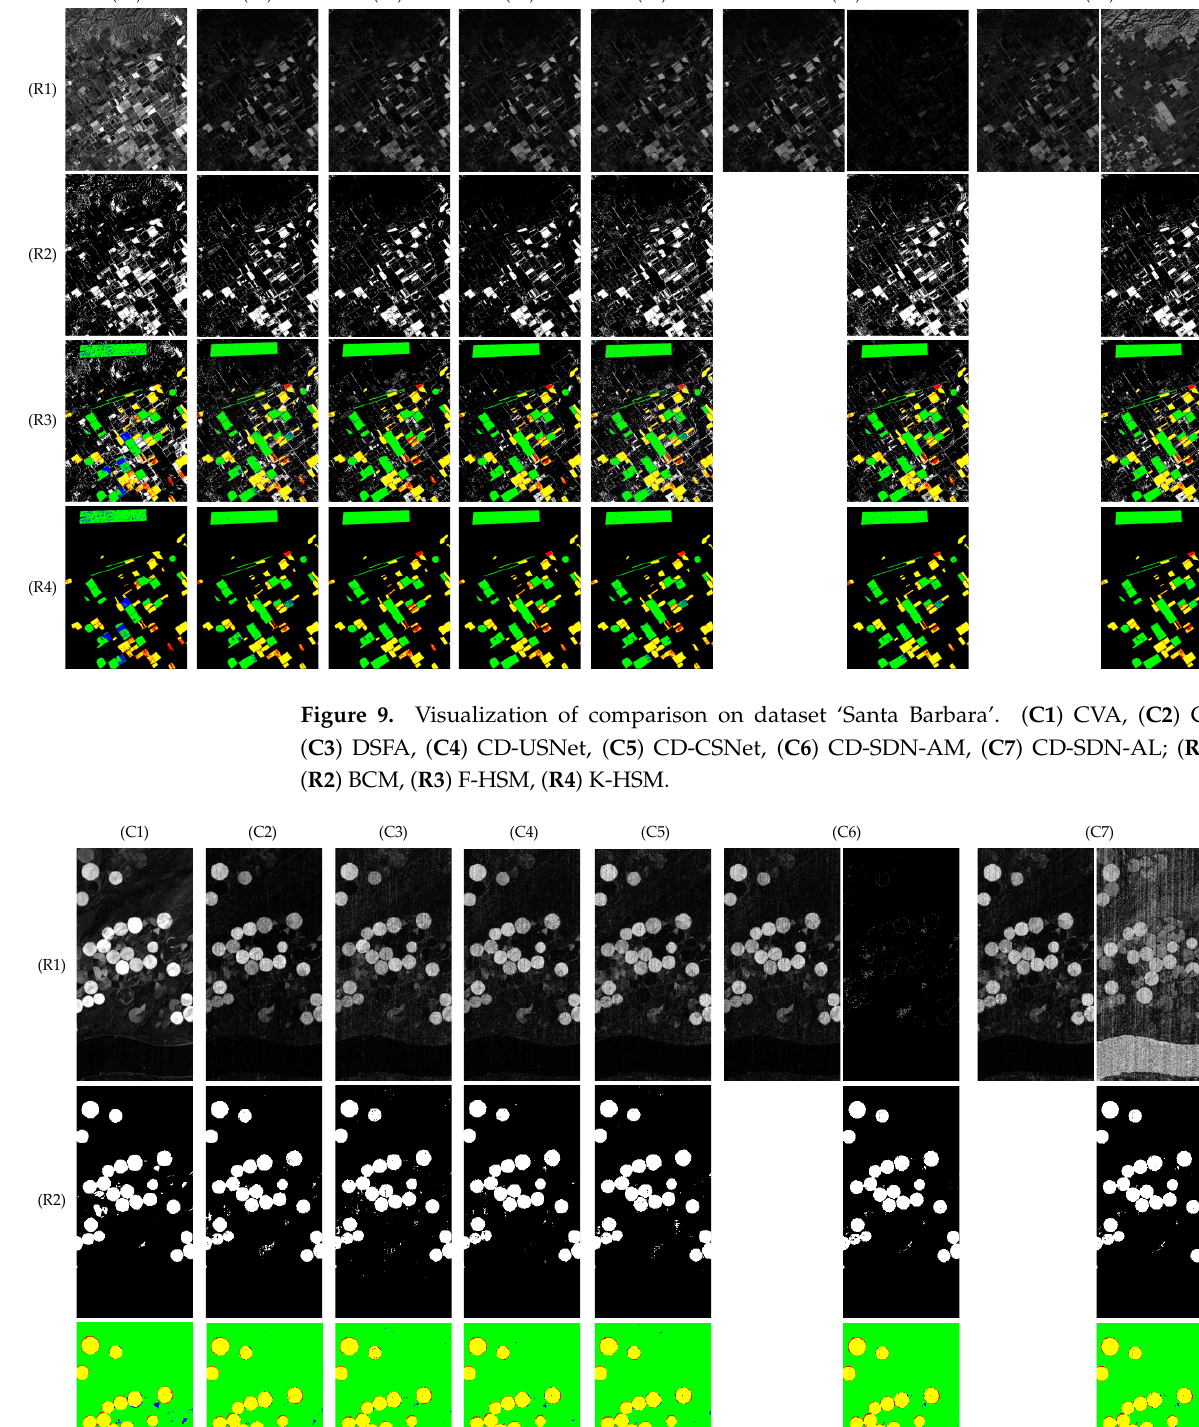
Figure 11. Visualization of comparison on dataset ‘Bay Area’. ( C1 ) CVA, ( C2 ) CD-FCN, ( C3 ) DSFA, ( C4 ) CD-USNet, ( C5 ) CD-CSNet, ( C6 ) CD-SDN-AM, ( C7 ) CD-SDN-AL. ( R1 ) CPM, ( R2 ) BCM, ( R3 ) F-HSM, ( R4 ) K-HSM.